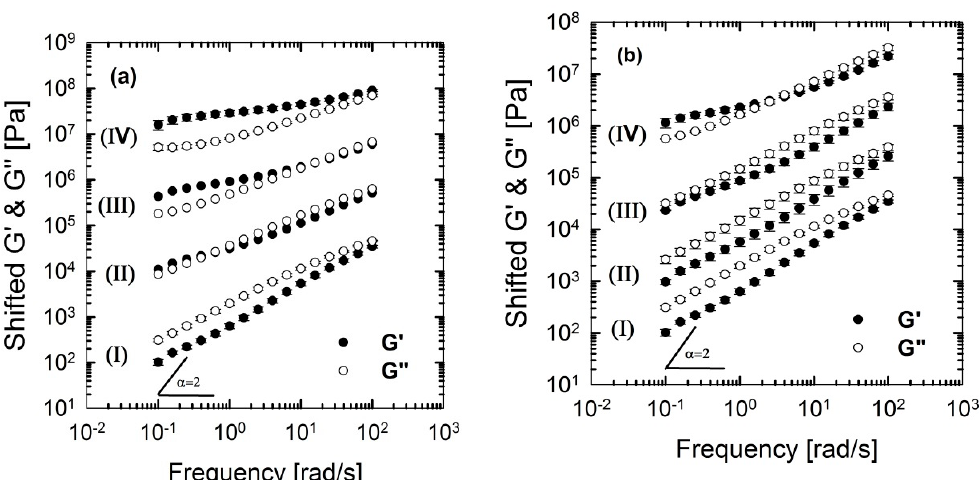
Figure 11. Storage (elastic), G ’( ω ) and loss (viscous), G ”( ω ) moduli of the PLA/PBS/J blends, for various concentrations of ( a ) C30B and ( b ) BET, at 190 °C. Moduli are arbitrarily shifted by 10° (I = 0 wt % clay), 10 1 (II = 1.5 wt % clay), 10 2 (III = 3 wt % clay) and 10 3 (IV = 5 wt % clay), respectively, for the sake of clarity. BET is Betsopa™, C30B is Cloisite ® 30B, and J is Joncryl.